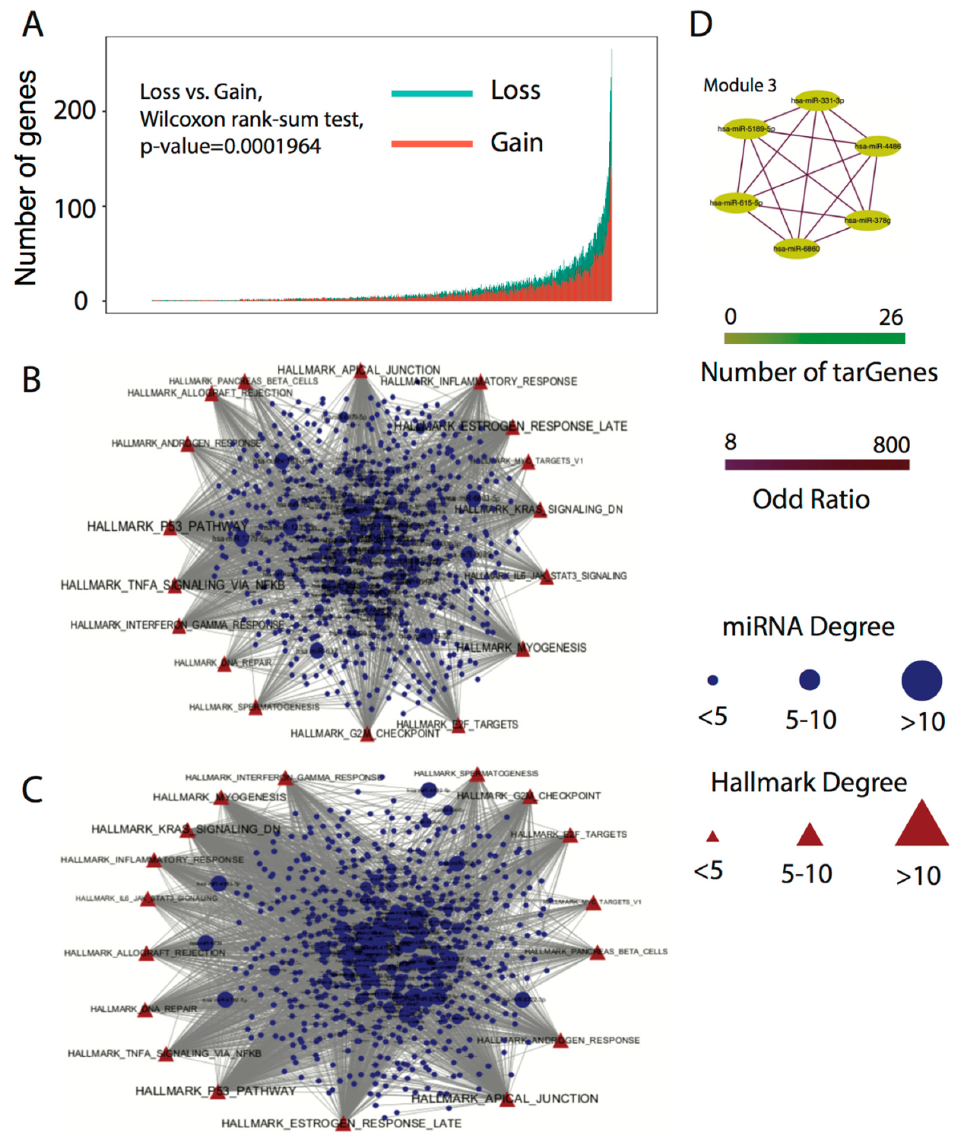
Figure 5. ( A ) Influence of miRNAs on genes. Red bar represents the number of genes bound by miRNA which re-gained binding sites. Blue bar represents the number of genes that were free from miRNA due to the loss of binding sites; ( B ) Connections between tumor hallmarks and miRNAs in the loss status; ( C ) Connections between tumor hallmarks and miRNAs in the gain status; ( D ) The miRNAs in gain module of miRNAs in gain status.